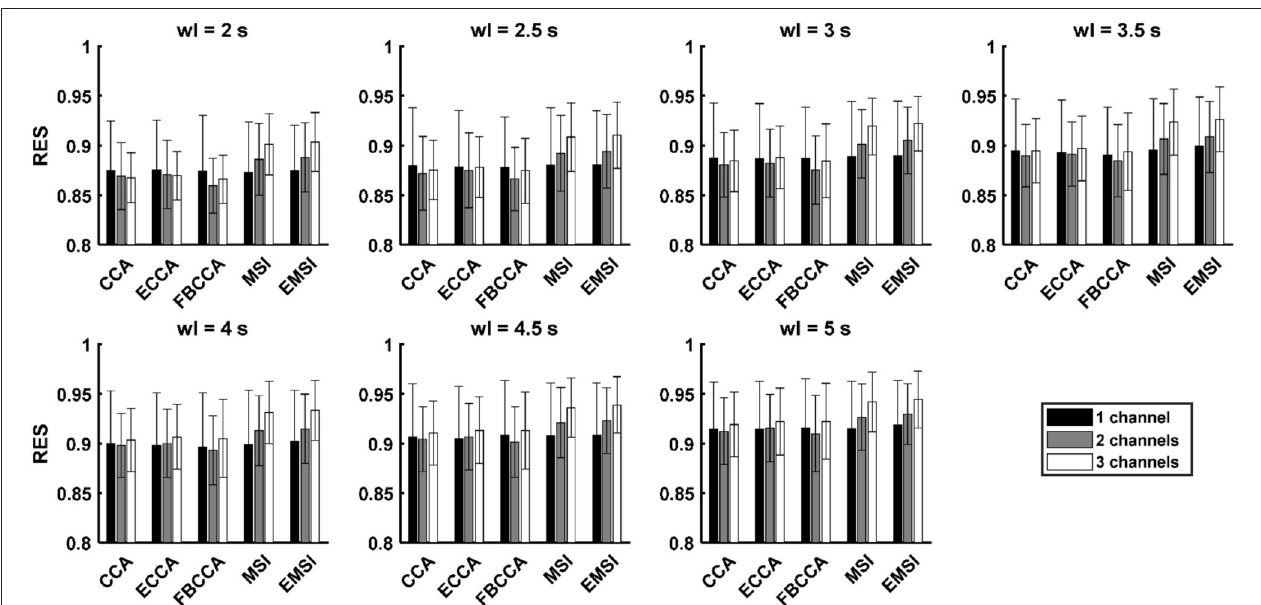
FIGURE 3 | Mean and standard deviation of the robustness to the electrode shift (RES) across the subjects with five SSVEP classification algorithms in the case with the number of channels as 3 and window length (wl) as 7 (black, gray, and white bars denote the mean accuracies in the cases with the number of channels as 1, 2, and 3, respectively; the error bars represent standard deviations of